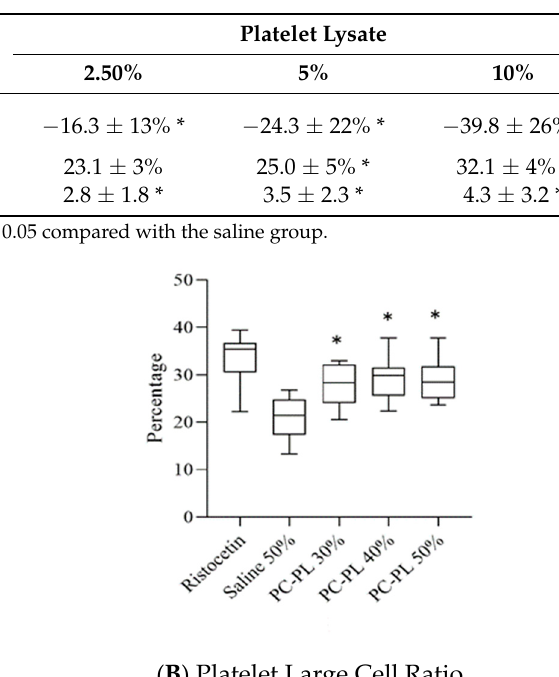
Table 1. Changes in platelet concentration, platelet large cell ratio, and platelet per aggregate in different constituents of platelet lysate and platelet-rich plasma.